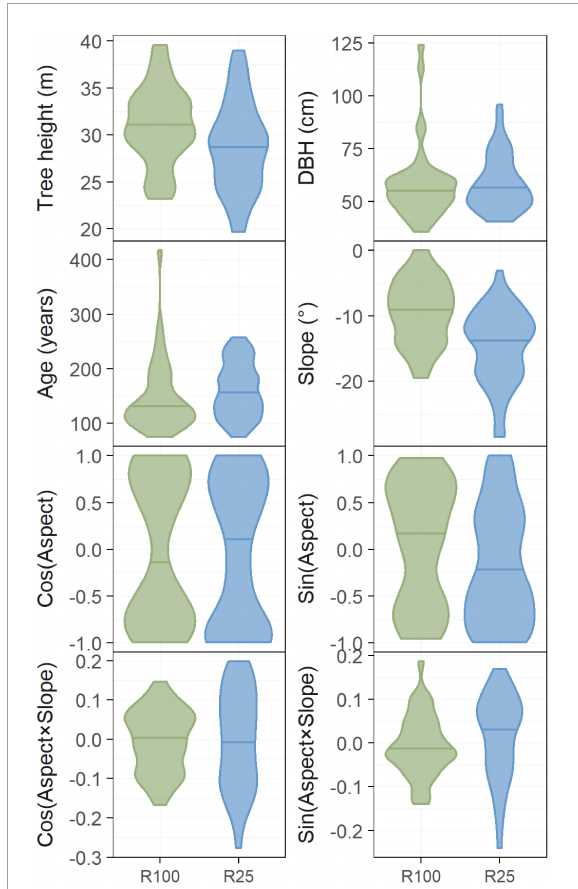
FIGURE3 Comparison of differences between treatments in tree height, diameter at breast height (DBH, 1.3 m) and tree age (at 1.3 m, 17 years after treatment), slope ( ◦ ), the cosine and sine of aspect, as well as the cosine and sine of aspect multiplied by the slope at each tree location. The distribution of values is indicated by the violin plots, and the median is indicated by horizontal lines. No significant differences were found for any of the tree or tree-location